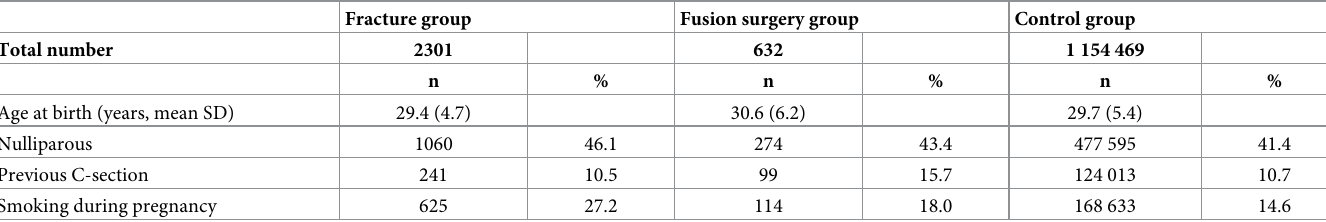
Table 1. Background characteristics of women having singleton pregnancies in the patient groups and control group.